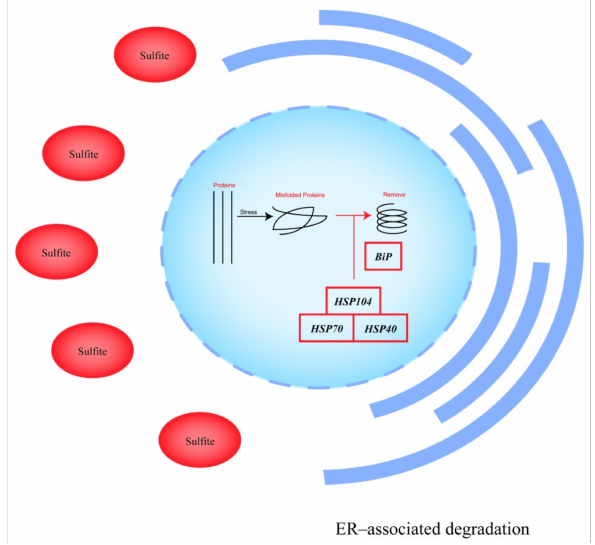
Figure 5. Map of protein processing pathways in the endoplasmic reticulum of A9- MET4 in a sulfite environment. The main upregulated genes in the figure are: (a) HSP104 , which regulates the expression of the nucleotide-exchange factor ( NEF ), with an expression level Log2 value of 1.50; (b) KAR2 , which regulates the expression of BiP (Binding immunoglobulin protein), with a Log2 value of 1.29; (c) SSA4 , which regulates the expression of the HSP70 family, with a Log2 value of 1.43; (d) APJ1 , which regulates the expression of the HSP40 family, with a Log2 value of 1.61. HSP104 combined with HSP70 and HSP40 activates denatured protein refolding under stress conditions [26].